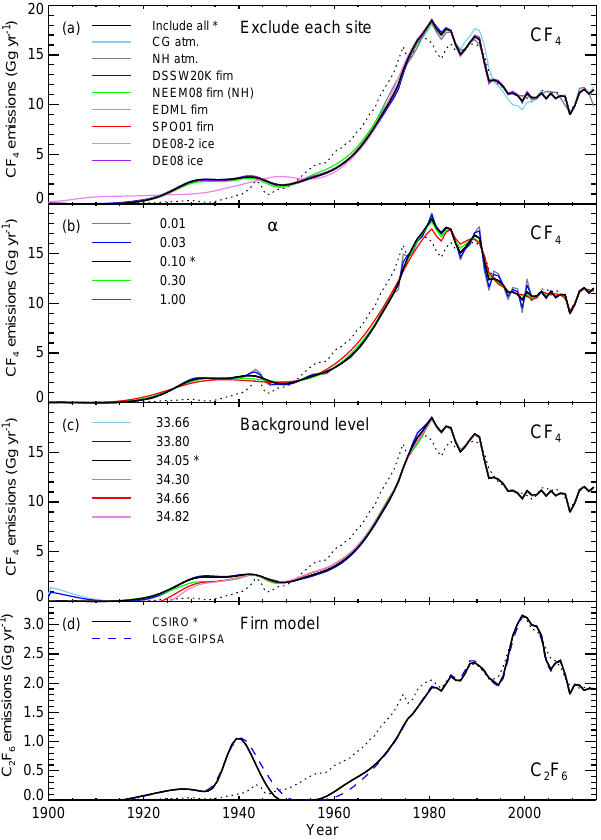
Figure 5. (a) CF 4 emissions estimated by InvE2 with measurements from all sites (black) and with each site excluded one at a time. (b) CF 4 emissions estimated using alternative values of the regular- isation parameter α . (c) CF 4 emissions estimated using alternative values of the pre-anthropogenic background level. (d) C 2 F 6 emis- sions inferred with the preferred Green’s functions from the CSIRO (black solid line) and LGGE-GIPSA (blue dashed line) firn mod- els. In all panels, our standard case is indicated in the legend by an asterisk, and the prior emissions are shown by the dotted